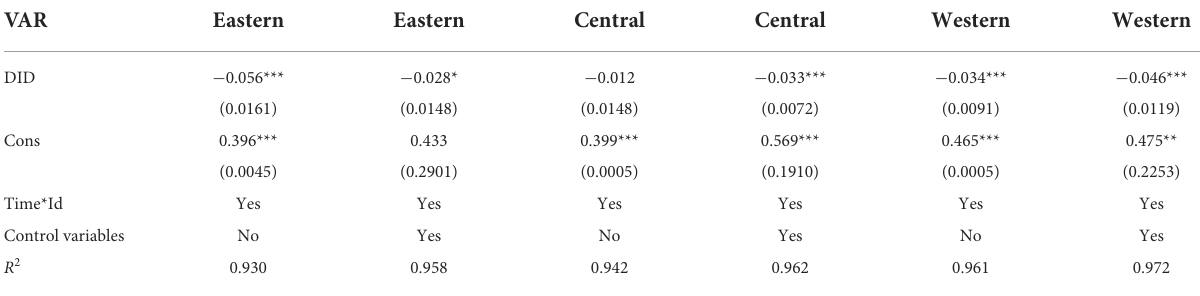
TABLE 7 Results of regional heterogeneity.